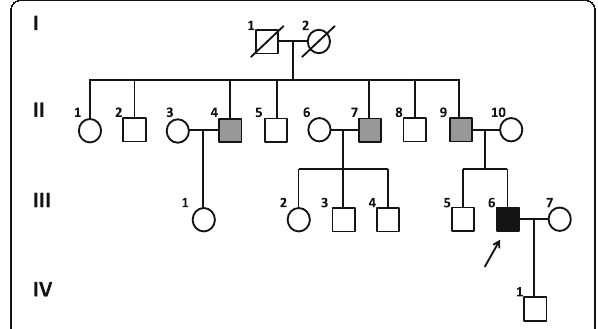
Fig. 1 Pedigree of BDHS family. The index patient is marked by an arrow. Black symbol, BHDS confirmed by mutation analysis; grey symbols, clinical suspicion of BHDS